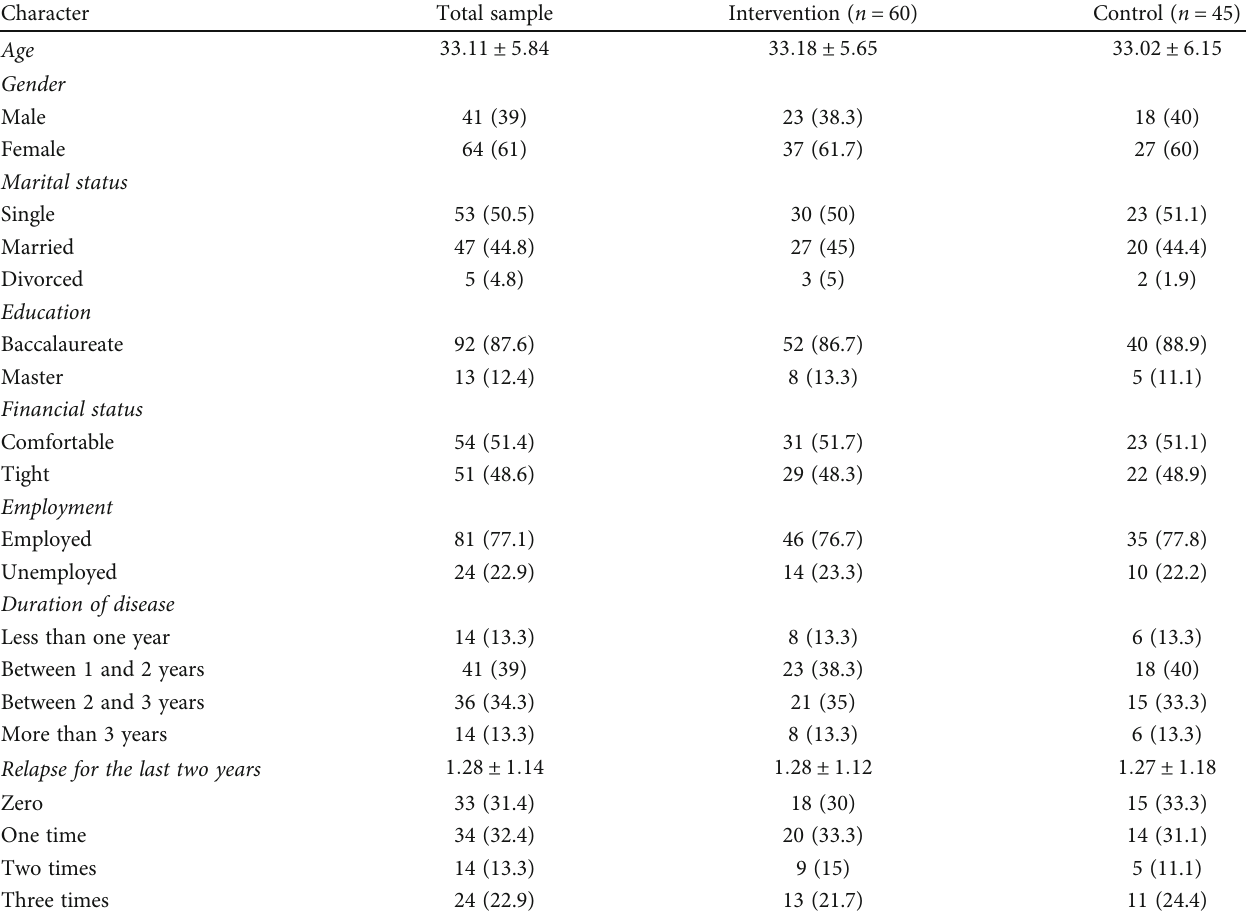
Table 1: Sociodemographic characteristics of the sample ( N = 105